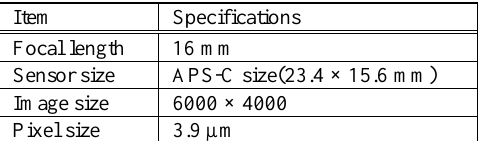
Table 2. Digital camera specifications